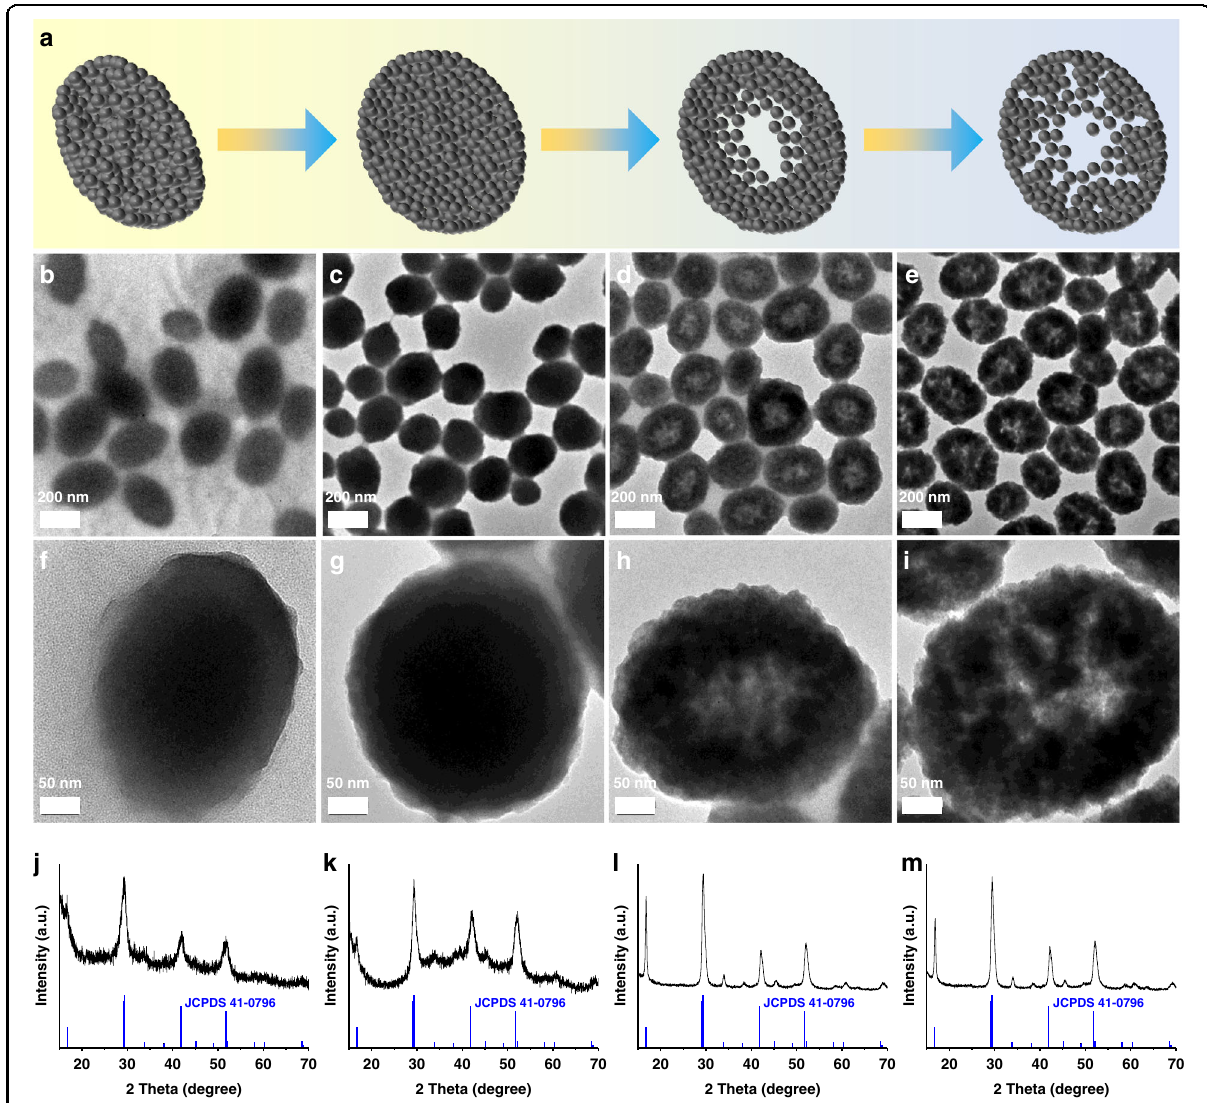
Fig. 2 Structural characterization of NBFYE nanoparticles synthesized at different reaction times. a Schematic illustration of the morphological evolution of nanoparticles over time. TEM images ( b – i ) and XRD patterns ( j – m ) of NBFYE nanoparticles synthesized by adding 1.5 g PAA and 5 mL H 2 O to the reaction system for different reaction times. ( b , f , j ) 0 h, ( c , g , k ) 1 h, ( d , h , l ) 5 h, and ( e , i , m ) 9